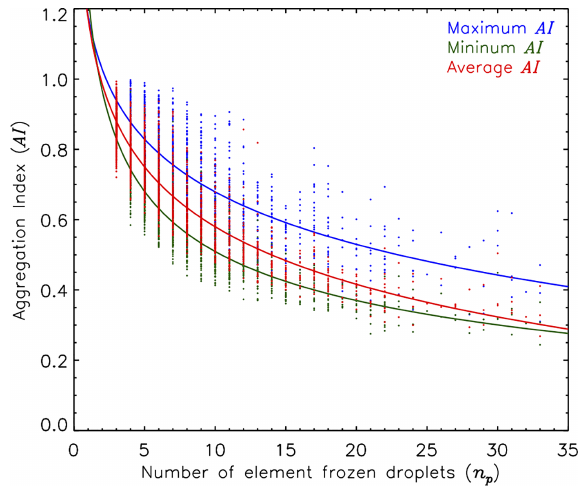
Figure 8. The calculated maximum (blue), minimum (green), and average (red) aggregation index (AI) of FDAs (circles) as a function of the number of element frozen droplets. Best-fit lines are shown using solid lines.